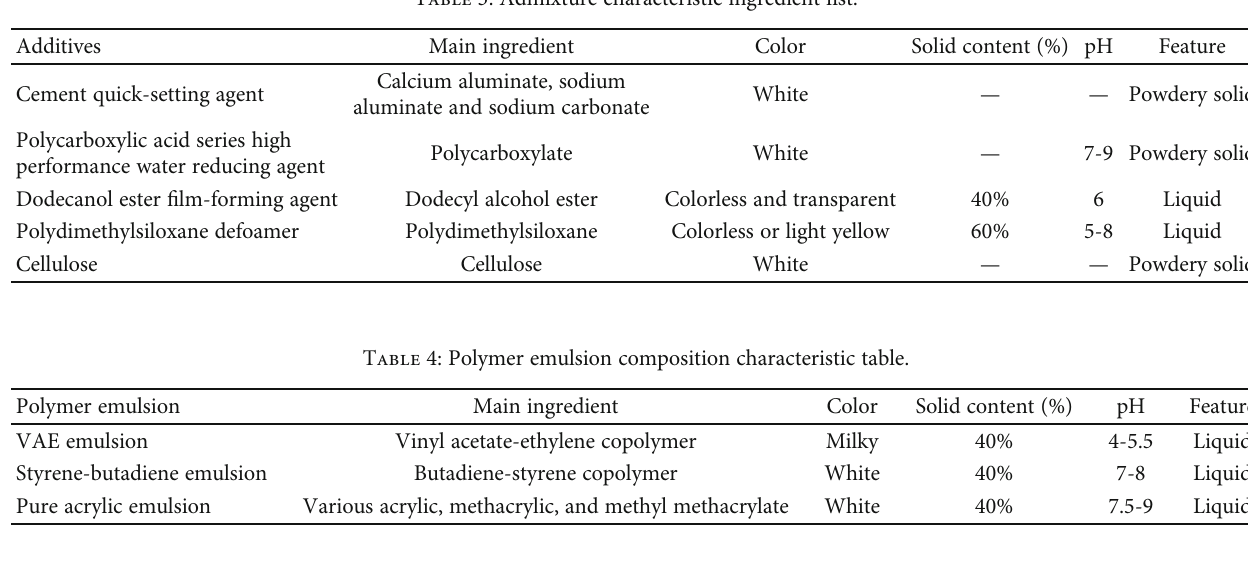
Table 3: Admixture characteristic ingredient list.